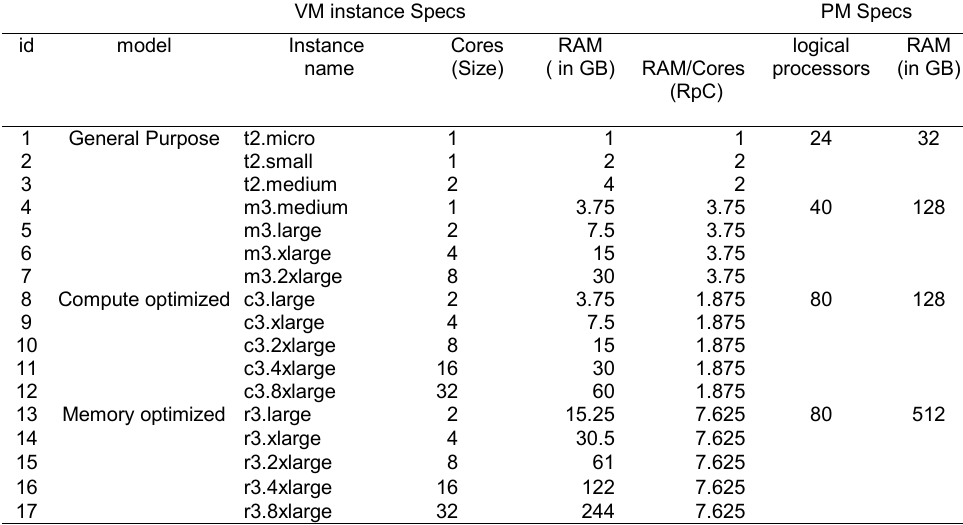
Table 3. Standard VM instances from Real Dataset – EC2, their resource ratio and